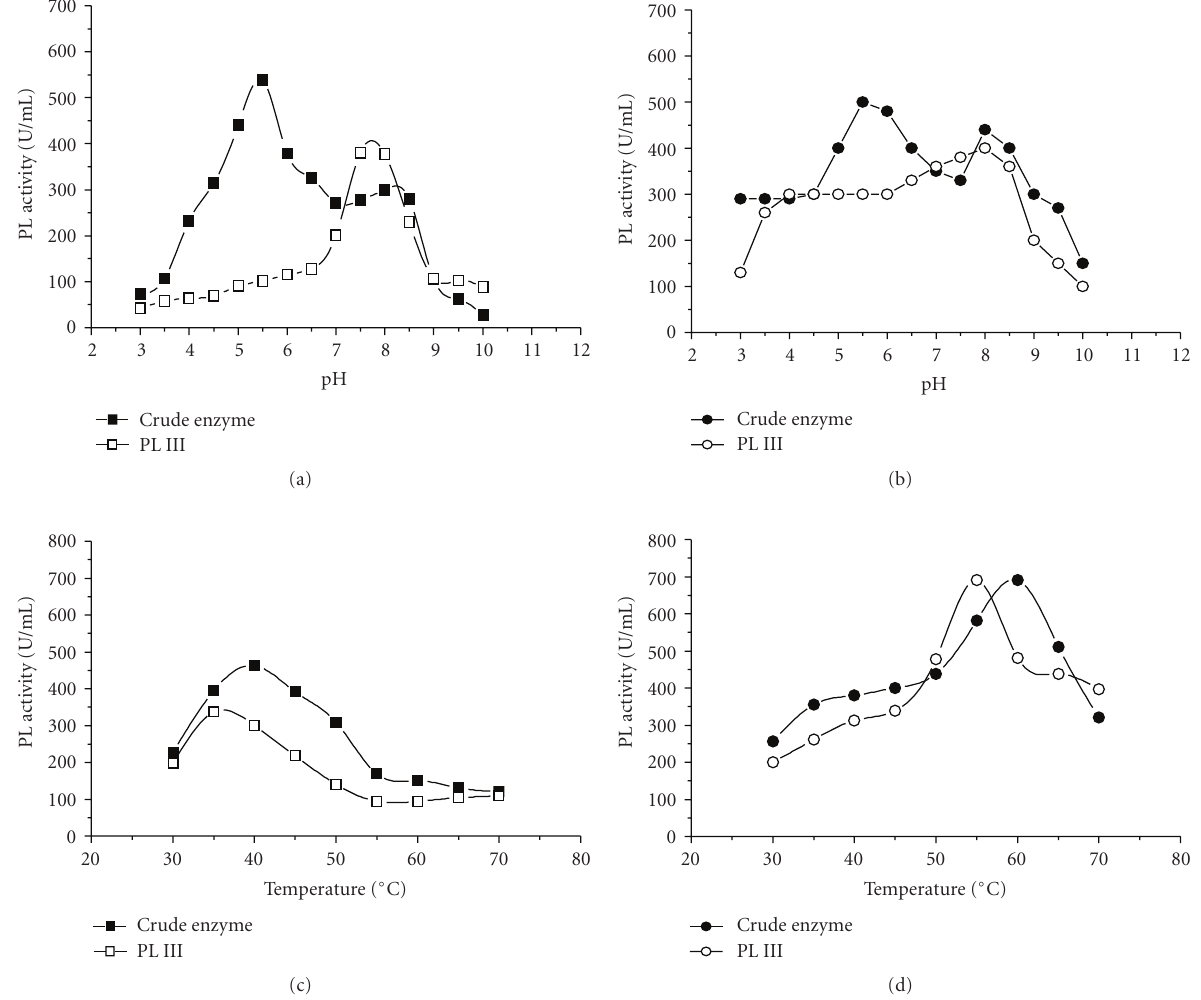
Figure 4: Physicochemical activity profiles of PLs obtained from P. viridicatum by SSF (a; c) and SmF (b; d). ( / ) = crude enzyme; ( / ) = fraction III obtained by Sephadex-G75